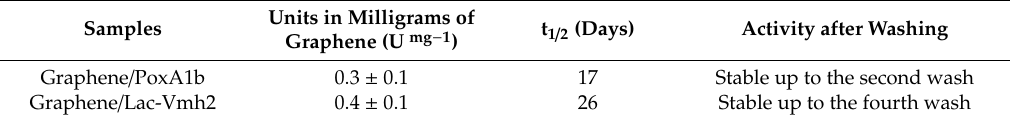
Table 1. Summary of the sample enzymatic activity and their characteristics. Samples